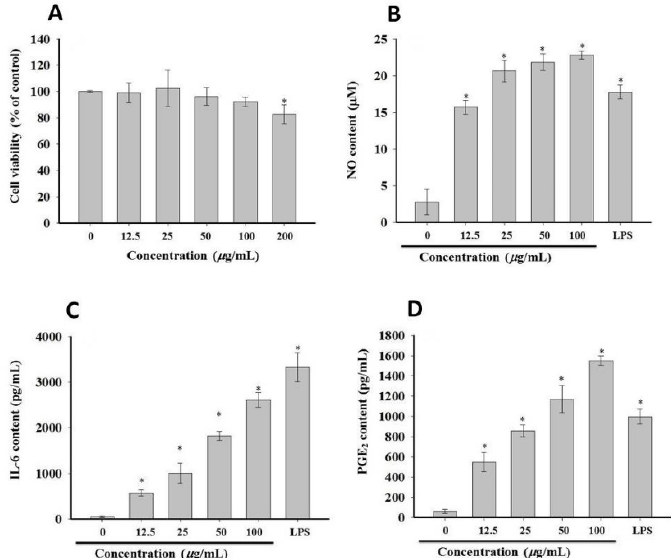
Figure 4. Effect of polysaccharide on the production of inflammatory mediators. ( A ) RAW 264.7 cells treated with different concentrations of polysaccharide, and cell viability was evaluated by MTT assay. ( B – D ) The NO content was detected by Griss reagent assay, and IL-6 and PGE 2 was evaluated by commercial kit. * p < 0.05 vs. control group.